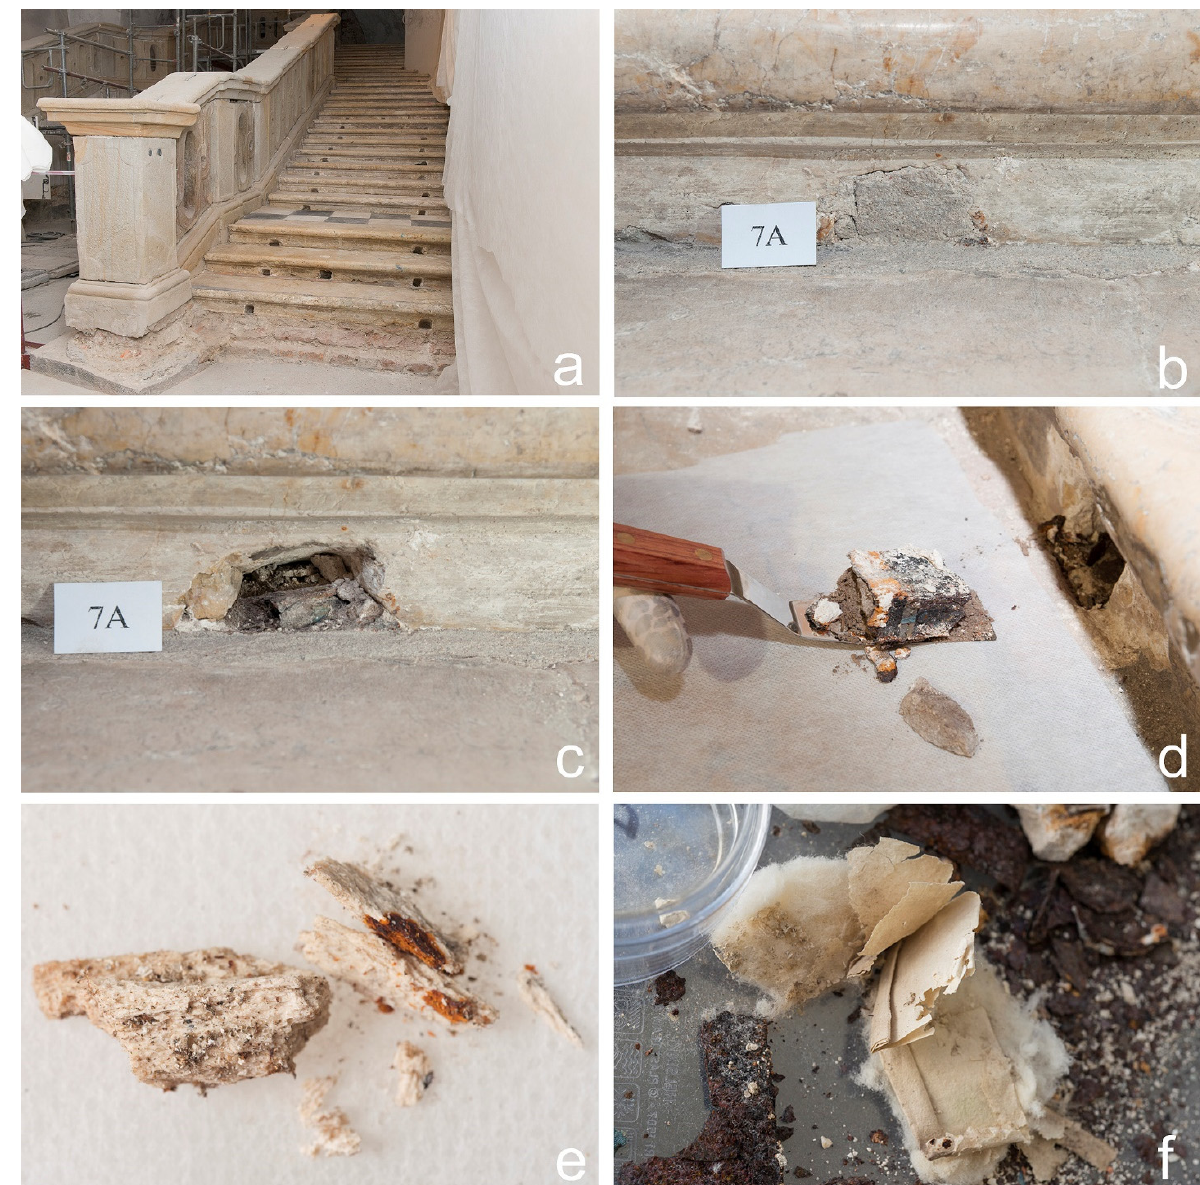
Figure 2. A view of a fragment of the right flight of the Holy Stairs in the monastery of the Piarists in Cracow. Condition during conservatory work. ( a ) Right flight of stairs after the removal of contents from all openings. ( b ) Soiled mortar that masks opening no. 7A with relics. ( c ) Opening no. 7A with removed masking mortar. ( d ) Contents of a sample opening taken out from a riser. ( e ) A fragment of bone tissue from one of the reliquaries. ( f ) Paper used to wrap bone fragments and cotton material.